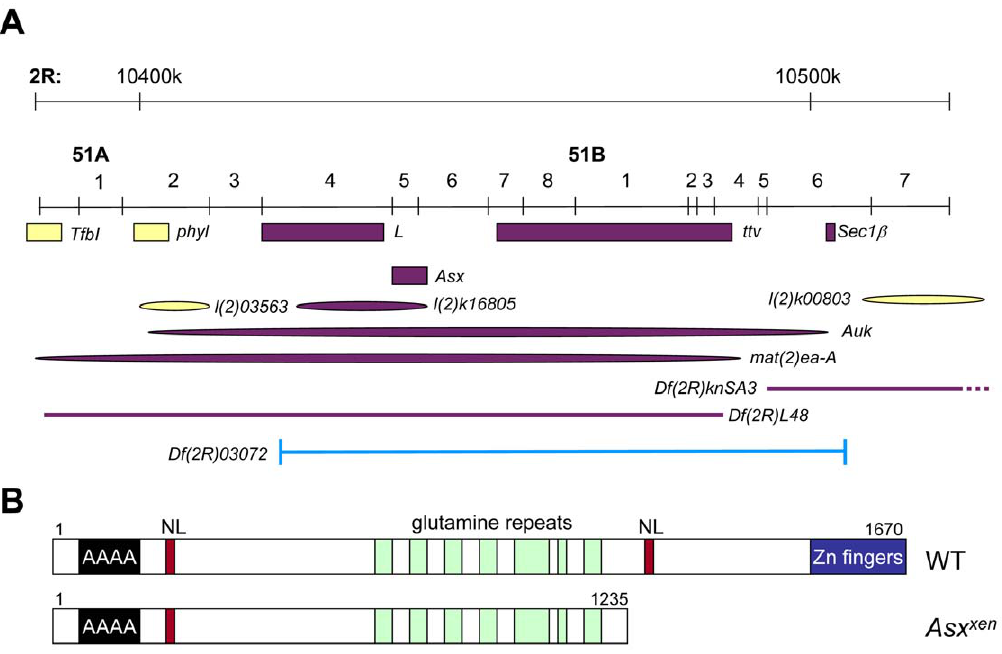
Figure 1. Identification of xenicid as an allele of AdditionalSexCombs ( Asx ). A) Maps of the genomic region from 50F-51B and nucleotides 10,400,000–10,500,000 on the right arm of the second chromosome, adapted from www.flybase.com. Genes (boxes), P-element insertions (ovals) and deficiencies (lines) that fail to complement Df(2R)03072 / CyO are colored purple. P-element insertions or genes that complement are colored yellow. The breakpoints of Df(2R)03072 are shown in blue. B) Schematic diagram of WT [18] and predicted mutant Asx proteins. Polyalanine (black box), nuclear localization sequences (red boxes), glutamine repeats (green boxes), and a cysteine-rich region predicted to form a double zinc finger (blue box) are indicated. The 14-base-pair deletion in exon 8 of Asx xen is predicted to result in production of a truncated version of Asx (1235 aa vs. 1670 aa in the wild-type protein) that lacks the C-terminal nuclear localization sequence and Zinc finger domains.